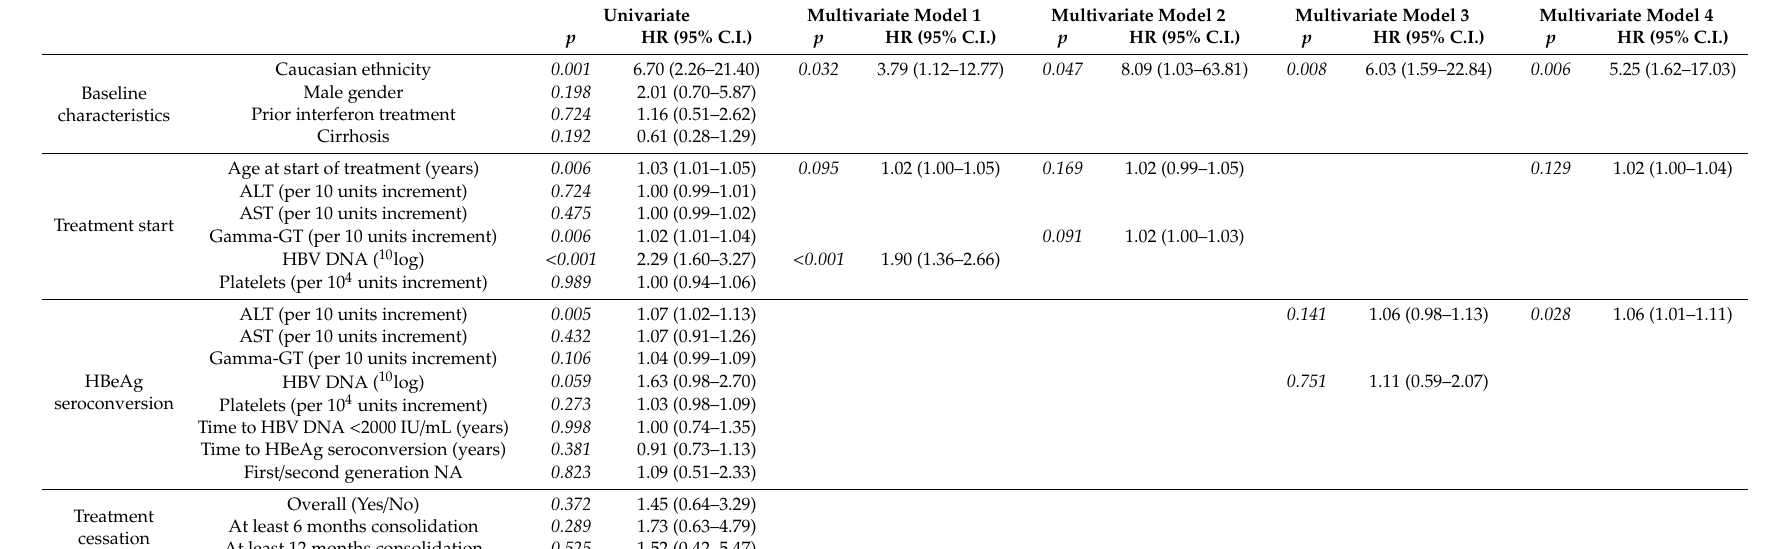
Table 2. Univariate and multivariate Cox regression model to predict HBsAg loss following treatment-induced HBeAg seroconversion in the entire patient cohort. HR: Hazard ratio, C.I.: Confidence interval, ALT: Alanine aminotransferase, AST: Aspartate aminotransferase, Gamma-GT: Gamma-glutamyl transferase. HBsAg: Hepatitis B surface Antigen, HBeAg: Hepatitis B e Antigen. Factors with p < 0.100 in univariate analysis were further investigated in multivariate models. Treatment cessation was investigated as a time-dependent